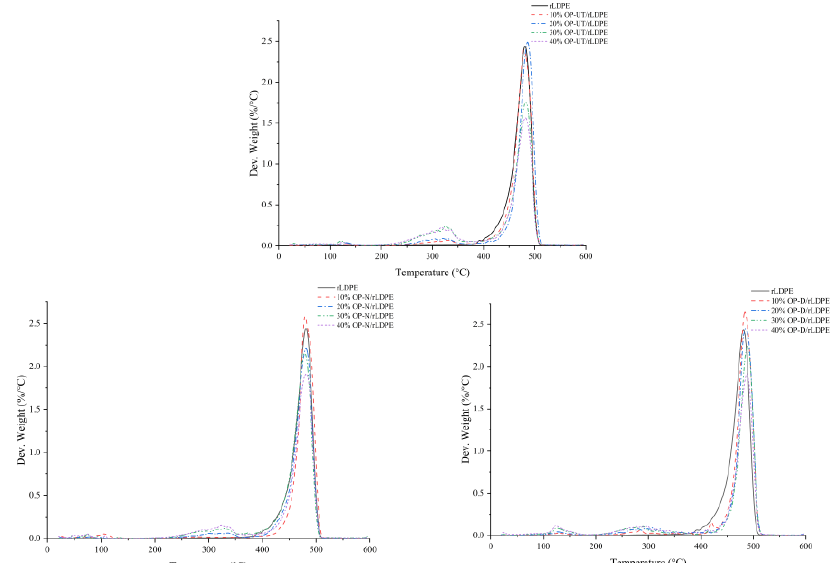
Figure 9. DTG curves of the developed biocomposites in comparison to rLDPE.